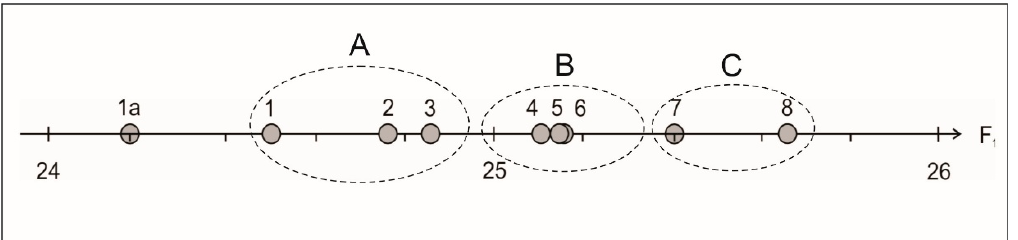
Figure 3. Location of compositions of Archaean metabasites in the Kola region compared to formations in Karelia, Canada, Greenland, on factor F 1 = 0.34SiO 2 − 0.46TiO 2 + 0.25Al 2 O 3 + 0.19 Σ Fe + 0.19MnO − 0.07MgO + 0.38CaO − 0.24Na 2 O − 0.57K 2 O [13]: 1a—ancient formations in Karelia, Canada,